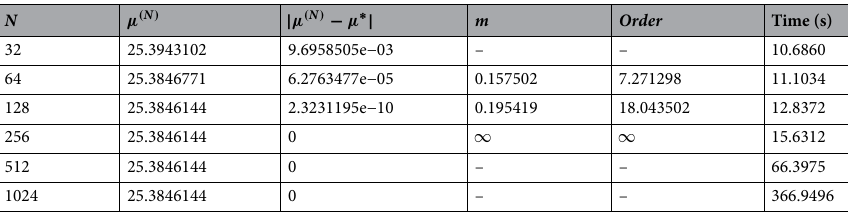
Table 3. The chemical potentials, the values of m and Order of the convergence rate and convergence order, respectively, and the execution time for 25.3846144 µ ∗ =